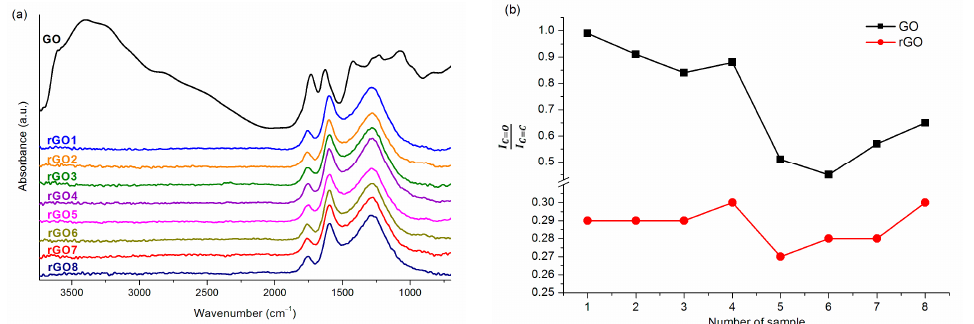
Figure 7. ( a ) FTIR spectrum for graphene oxide and rGO1–8; ( b ) The ratio of the area of the carbonyl group bands to the double bond bands between carbon atoms in aromatic rings I C = O oxides and reduced graphene